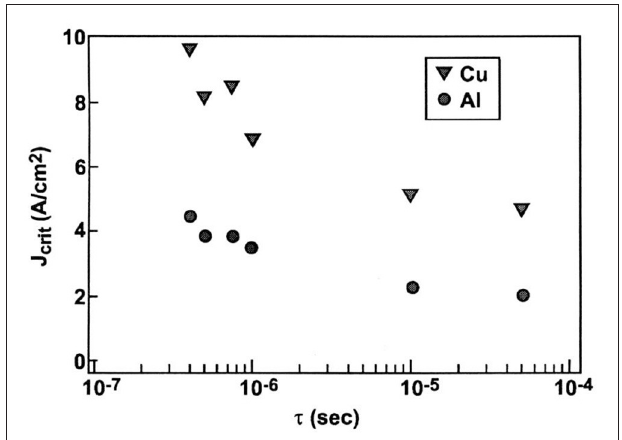
FIGURE 9 | Comparison of critical current to failure for copper and aluminum interconnects in 130nm CMOS technology (with permission from the ESD Association).